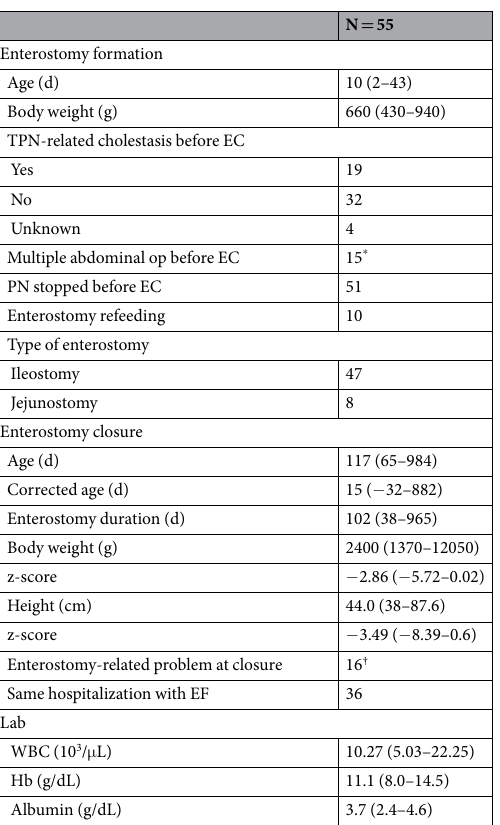
Table 3. Clinical characteristics with enterostomy formation and closure. EF: enterostomy formation, EC: enterostomy closure, TPN: total parenteral nutrition, PN: parenteral nutrition, WBC: white blood cell, Hb: hemoglobin. * Multiple abdominal op: 7 for complications after enterostomy, 3 for correction after primary closure or anastomosis, 1 for definite op after drainage procedure, 1 for 2 nd look op, 1 for intestinal biopsy d/t persistent delayed evacuation for contrast study, 1 for perforation during contrast study, 1 for transformation from jejunostomy to ileostomy. † Enterostomy -related problem: 6 for high output enterostomy, 3 for enterostomy prolapse, 3 for failure to thrive, 1 for both high output and prolapse, 1 for accidental, 1 for peristoma skin problem, 1 for parents’